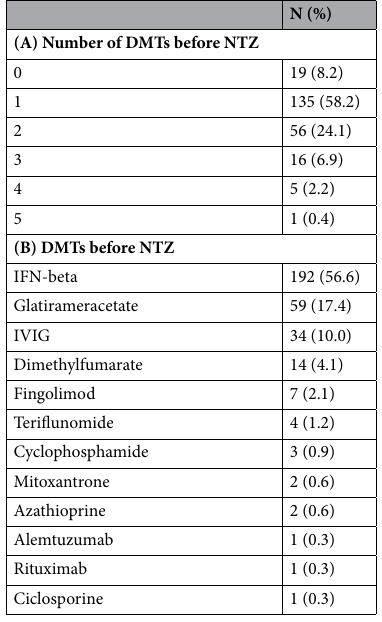
Table 1. Disease modifying treatment (DMT) before NTZ. A: Number of different DMTs before treatment start with NTZ in a total of 232 patients. B: Type of DMT before treatment start with NTZ. All DMTs per patient administered before NTZ were considered, resulting in 339 DMTs in 213 patients with pre-treatment. DMT disease modifying treatment, IFN interferon, IVIG intravenous immunoglobulins.